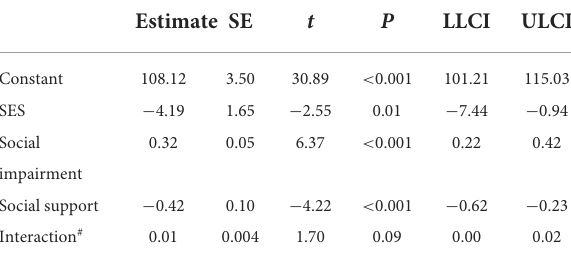
TABLE 5 Summary of moderation analysis for social